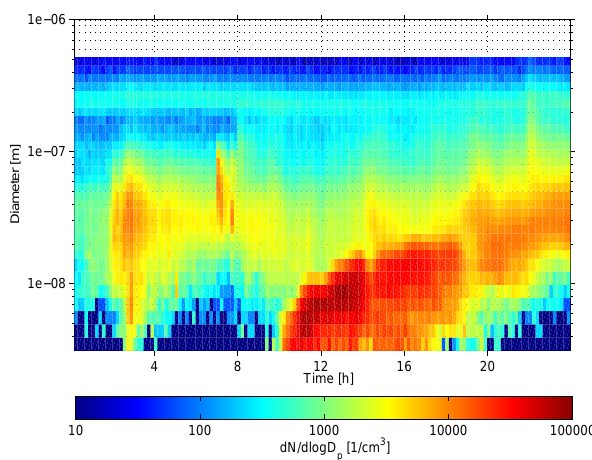
Fig. 5. The particle size distribution data measured by a DMPS in Hyyti ¨ al ¨ a, Finland, on 1 April